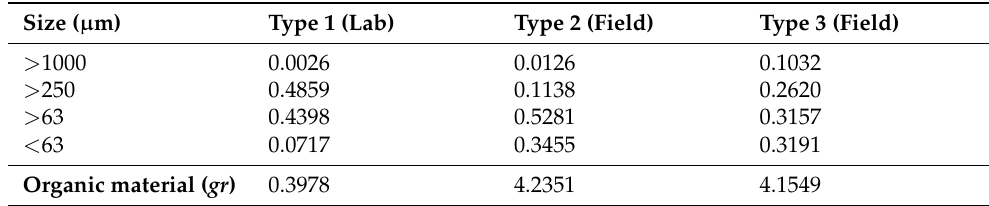
Table 1. Particle Size